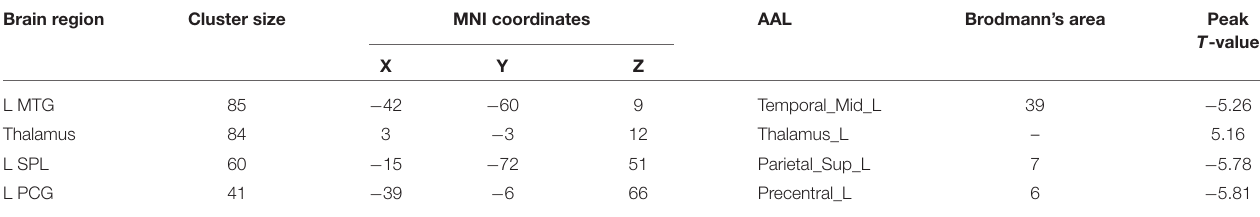
TABLE 2 | Brain regions showing significantly changed dynamic regional homogeneity in the trigeminal neuralgia (TN) patients compared to the healthy controls (HC). Brain region Cluster size MNI coordinates AAL Brodmann’s area Peak